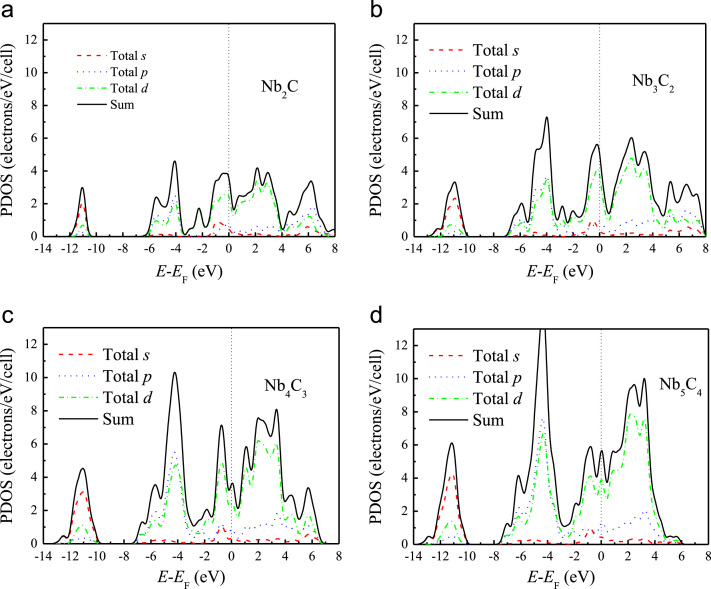
The PDOS of (a) Nb2C, (b) Nb3C2, (c) Nb4C3 and (d) Nb5C4.